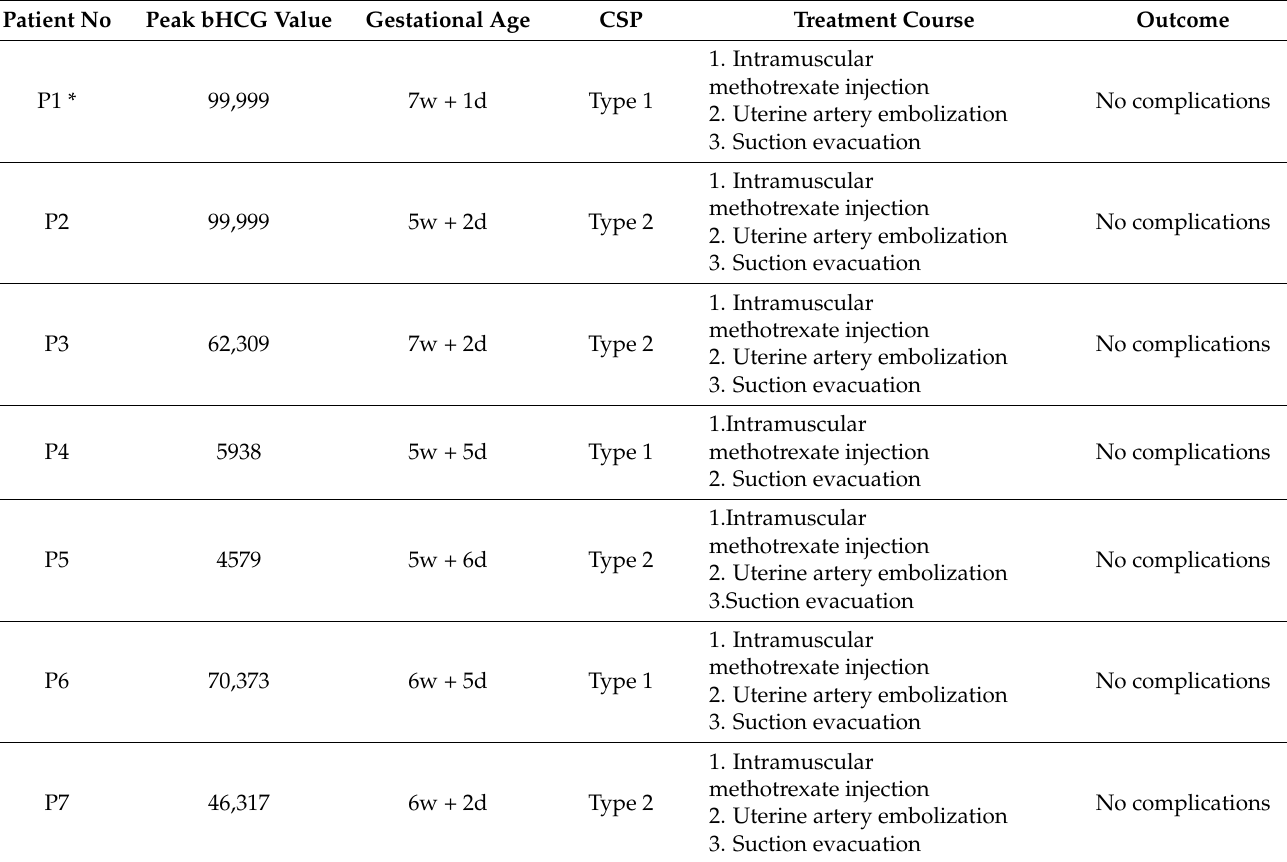
Table 1. Anonymized patient